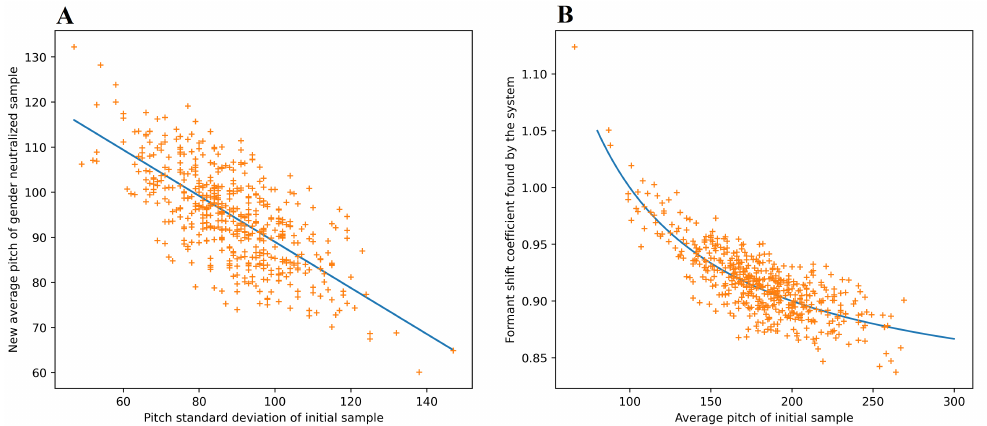
Figure 5. Correlation of initial sound features and correct transformation parameters for gender neutralization for female samples. Orange ‘+’ markers correspond to each sound sample and blue line is representing equation of corresponding correlation. ( A ) Correlation of initial pitch standard deviation and new pitch value of neutralized sound. ( B ) Correlation of initial average pitch to the formant shift coefficient in neutralized sound.